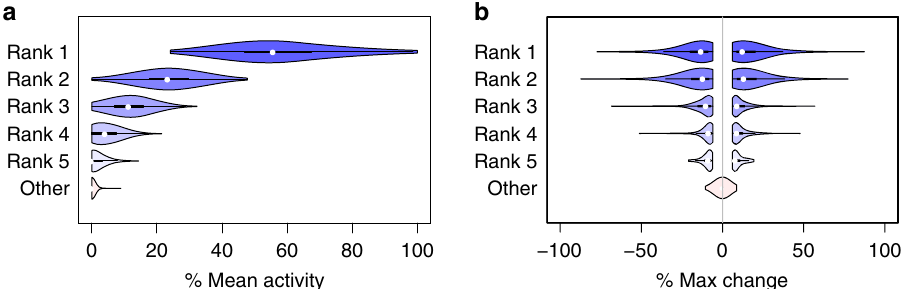
Fig. 6 PCAWG signature changes by activity level. a Mean signature activities ranked from the largest to the smallest within each sample in PCAWG data. Only the top fi ve signatures with the highest activities in a sample are shown. b Maximum changes of signature activities for the corresponding signatures on plot ( a ). The changes below 5% are omitted.